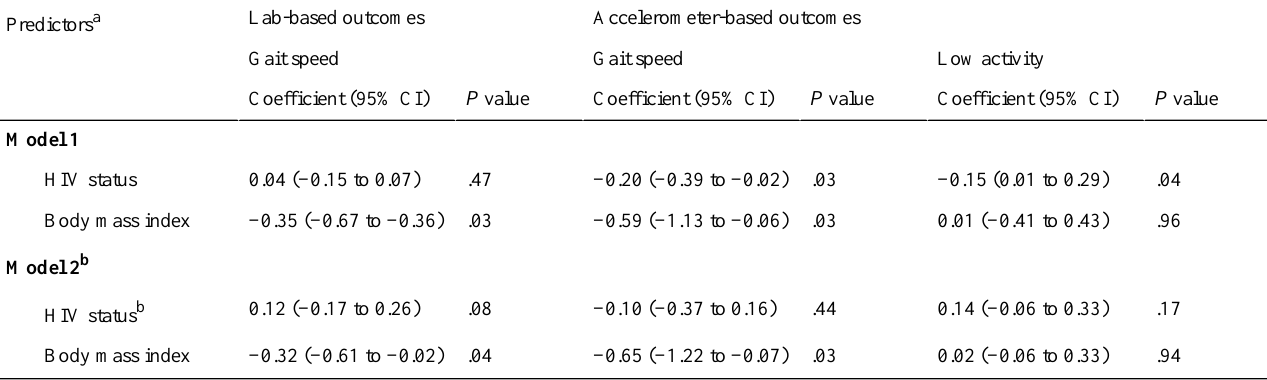
Table 5. Multivariate linear regression models for activity outcomes.